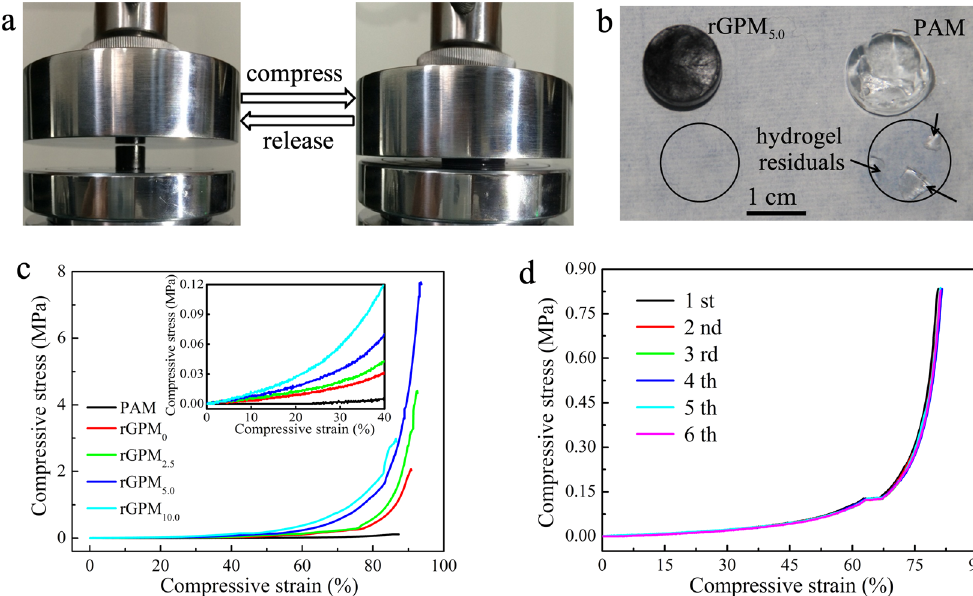
Figure 4. Photographs showing the rGPM 5.0 hydrogel before and after compressing at ε = 85% ( a ). Photos demonstrating the residues of rGPM 5.0 and PAM hydrogel after placed on a paper under a stress about 20 kPa for 10 min ( b ). Typical compressive stress–strain curves of PAM and rGPM ( c ). Stress–strain curves of rGPM 5.0 hydrogel under consecutively repeated loading at ε = 80% ( d